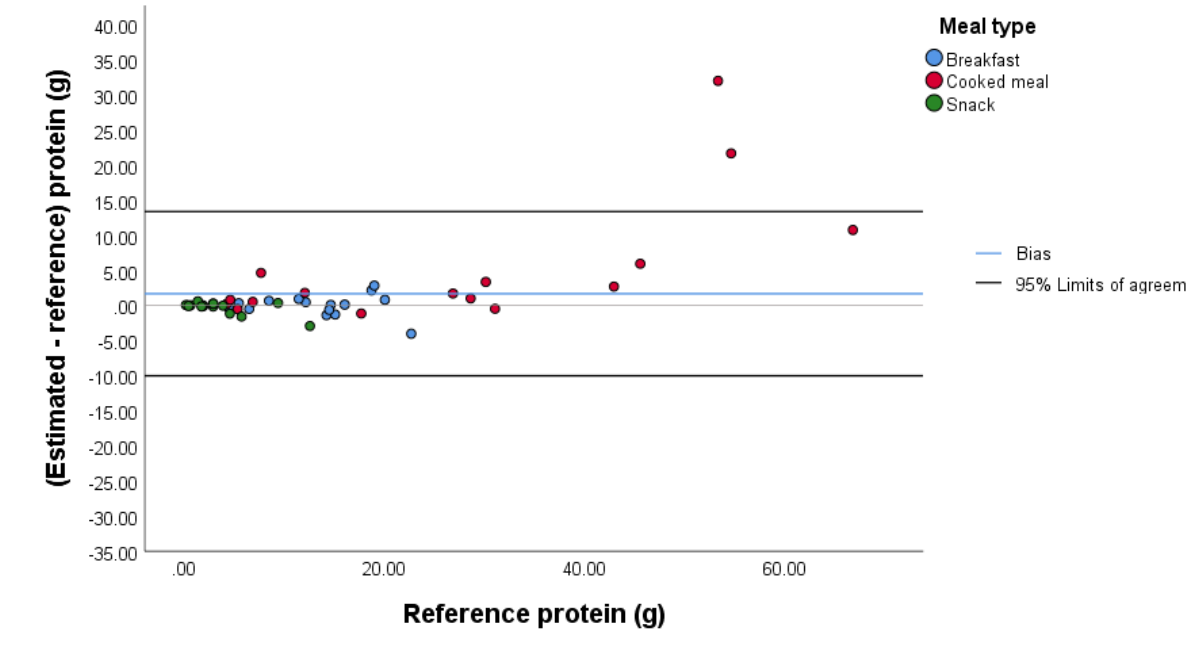
Figure 5. Bland-Altman plot illustrating the difference between the estimated and reference fat content of the